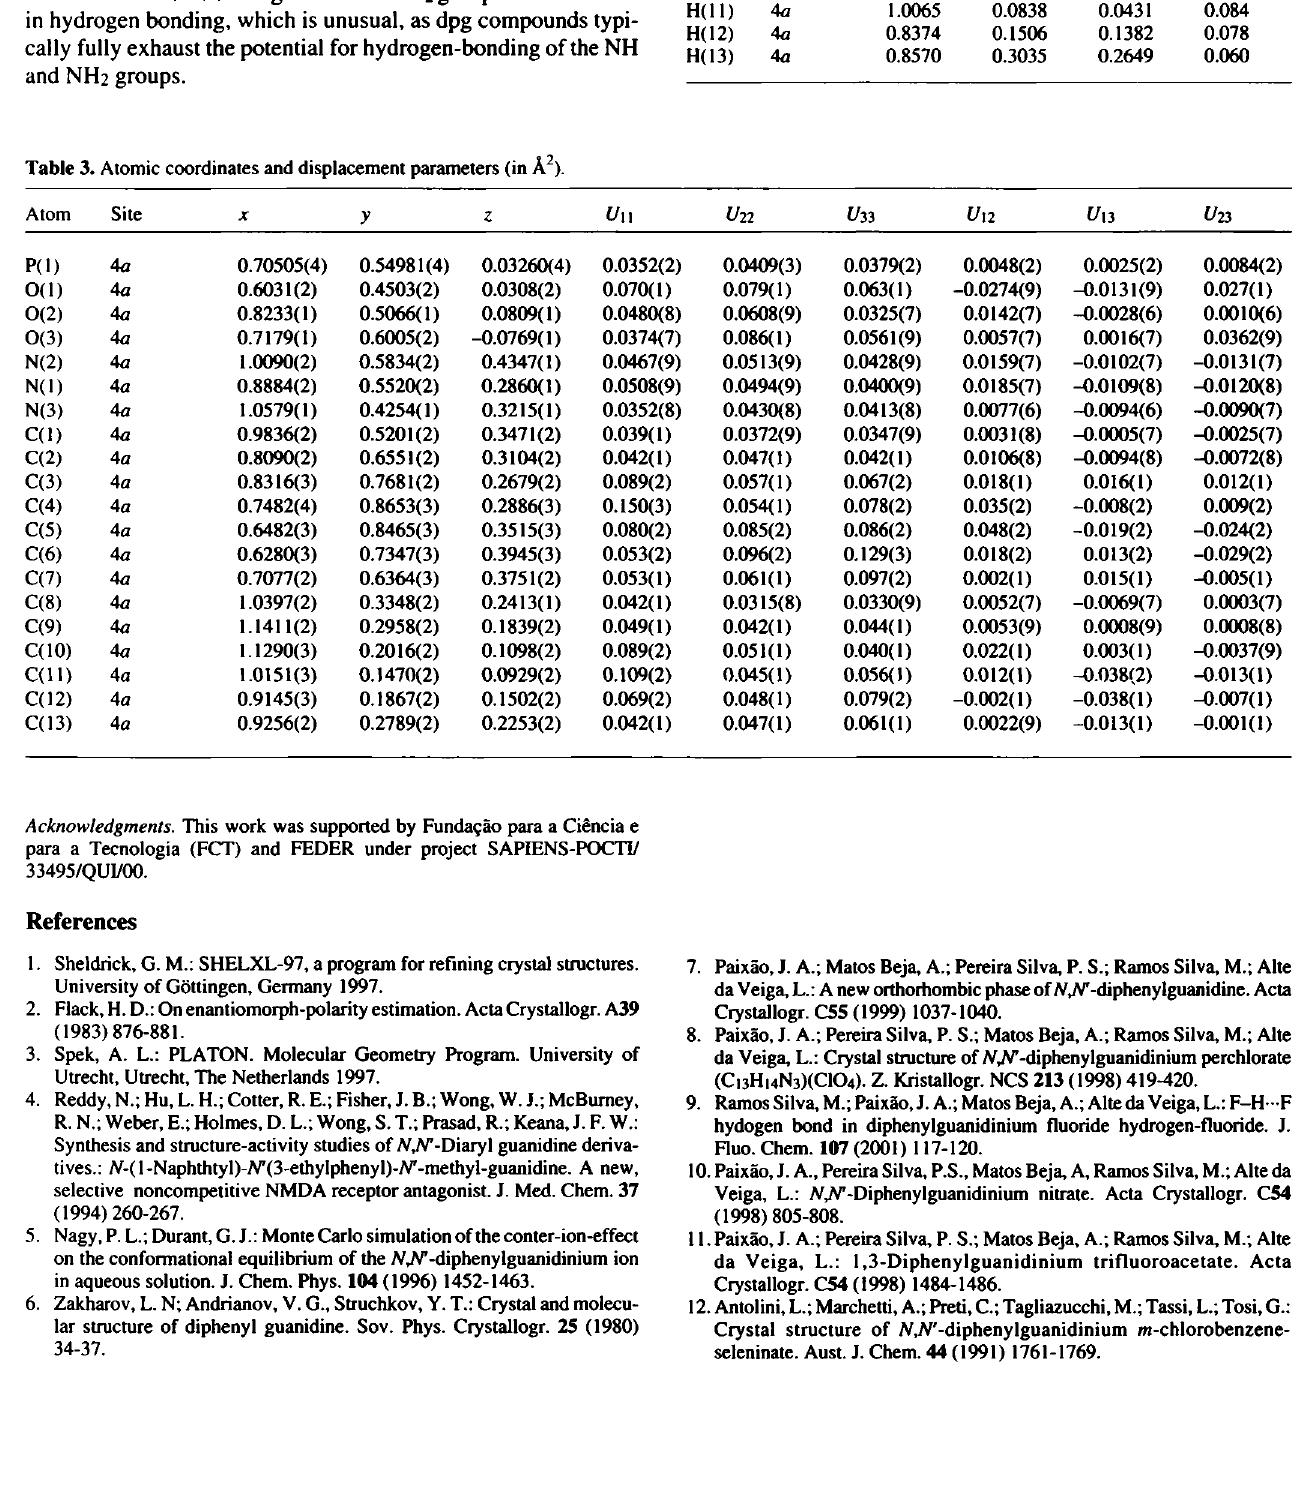
Table 3. Atomic coordinates and displacement parameters (in A 2 ).